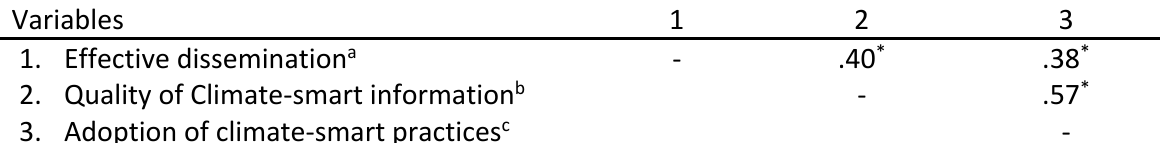
Pearson Correlation Statistics for Adoption of CSA by Quality and Effective Dissemination (N =